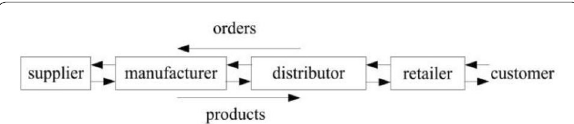
Figure 1 Simplified structural model of supply chain in discrete‑type manufacturing